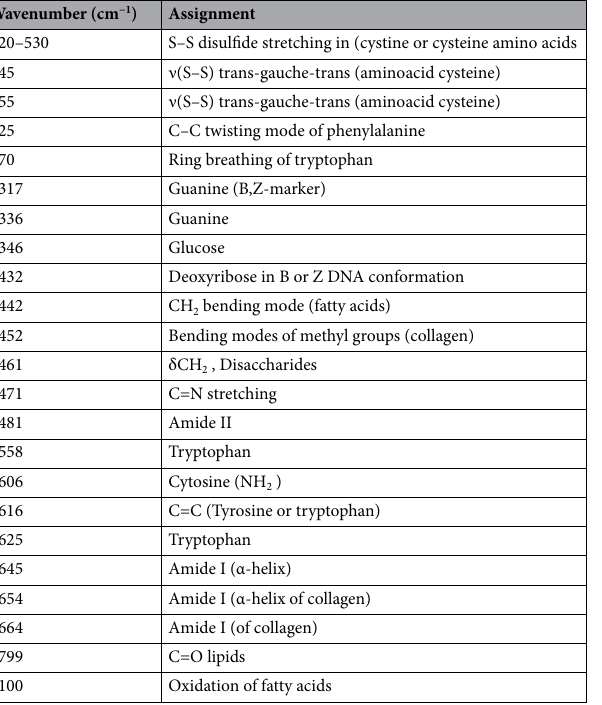
Table 1. Assignment of vibrational modes, based on refs. 18–21 .